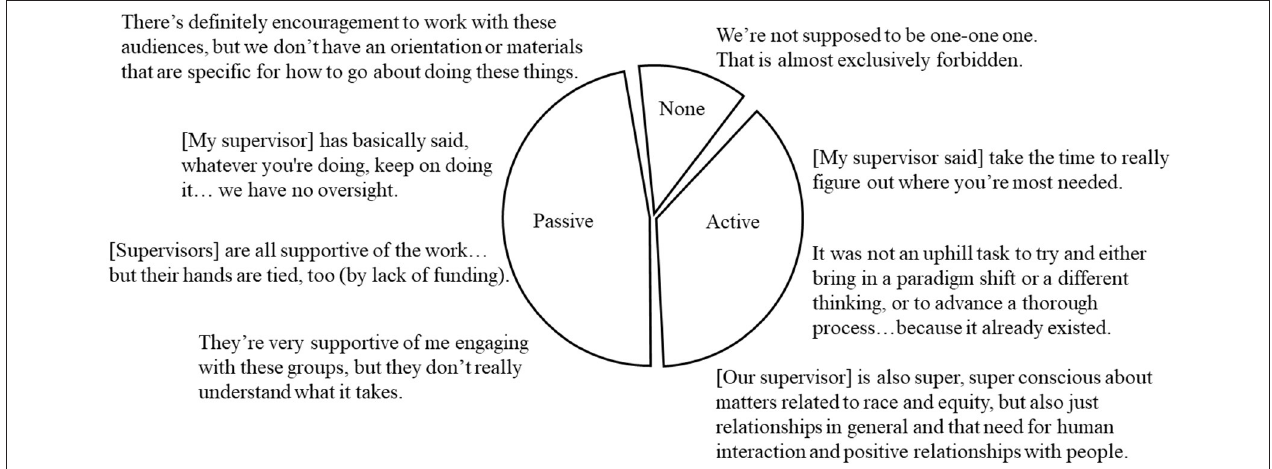
FIGURE 2 | Types of support as detailed by interviewees for conducting collaborative work with immigrant and minority